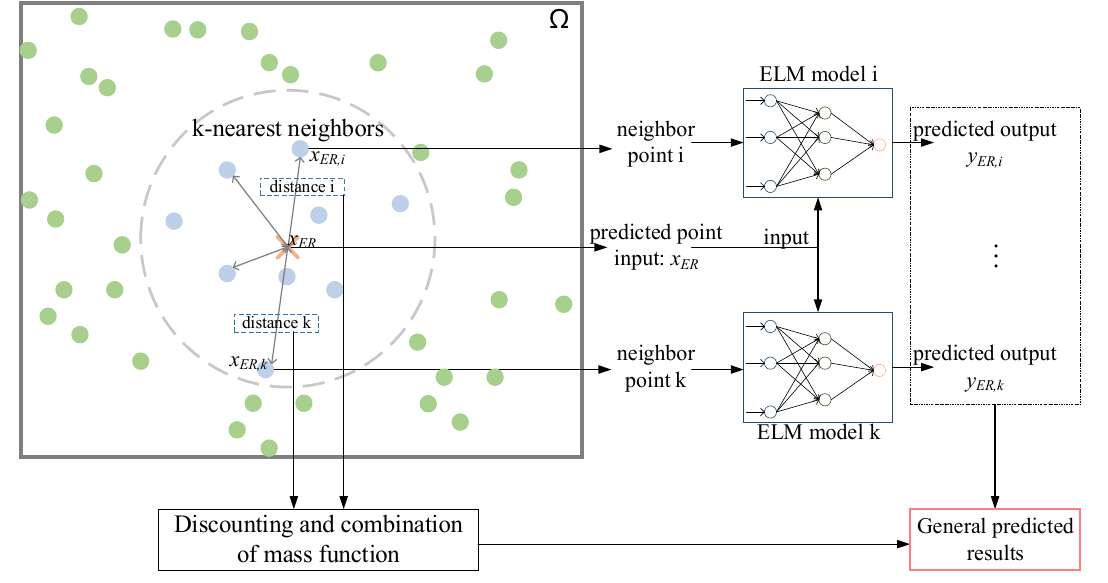
Figure 2. Schematic diagram of EELM.